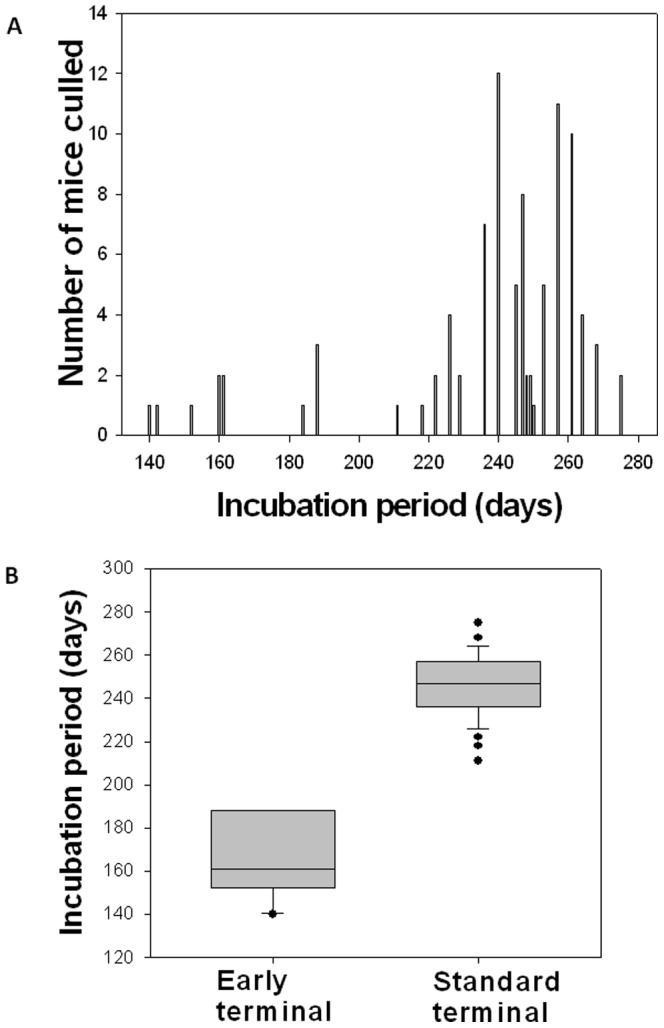
Comparison of the cull dates for the mice challenged via the gingival margin.Panel A; Frequency distribution plots show the presence of a normally distributed population with a mean incubation period of around 250 days plus a small number of animals with significantly shorter incubations ranging from 140–188 days. Panel B; when these two groups are compared they show distinct means and distribution and are considered as distinct populations (p<0.001).